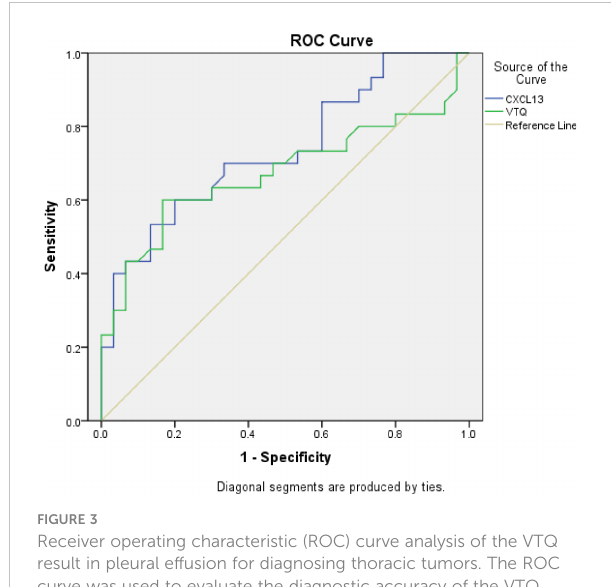
FIGURE 3 Receiver operating characteristic (ROC) curve analysis of the VTQ result in pleural effusion for diagnosing thoracic tumors. The ROC curve was used to evaluate the diagnostic accuracy of the VTQ result in pleural effusion for diagnosing thoracic tumors. The x-axis represents the false positive rate (1-speci fi city), and the y-axis represents the true positive rate (sensitivity). The diagonal line represents a random guess. The closer the curve is to the top left corner, the better the diagnostic accuracy. The area under the ROC curve (AUC) was 0.67 (95% con fi dence interval [CI]: 0.53-0.82). The sensitivity and speci fi city were 60.0% and 83.3%, respectively, and the optimal diagnostic cutoff was 3.33 m/s. The results indicate that the VTQ result in pleural effusion has a moderate diagnostic accuracy for thoracic tumors.